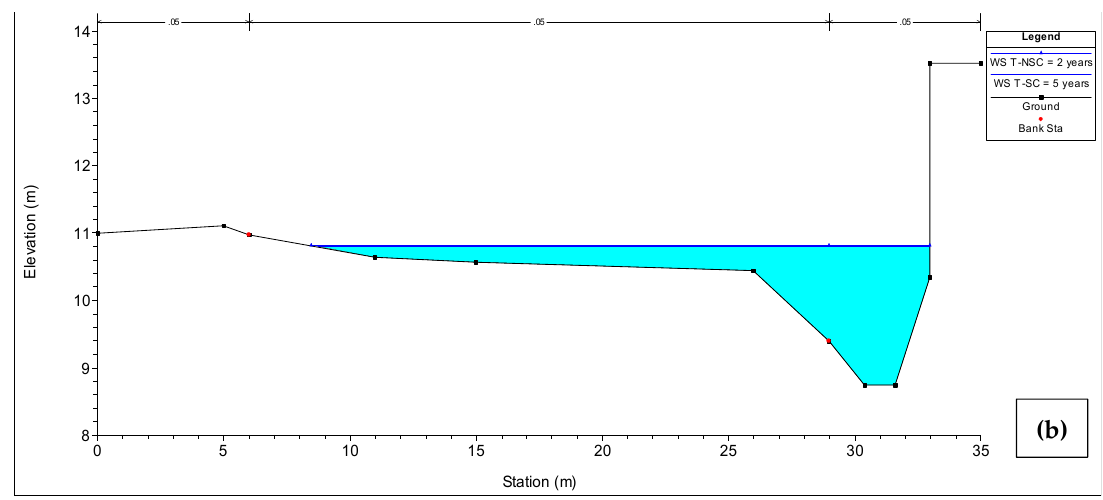
Figure 8. Natural cross-sections of Gordo creek. ( a ) Cross-section at K0+018.5; ( b ) cross-section at K0+178.5. WS indicates the water surface level.